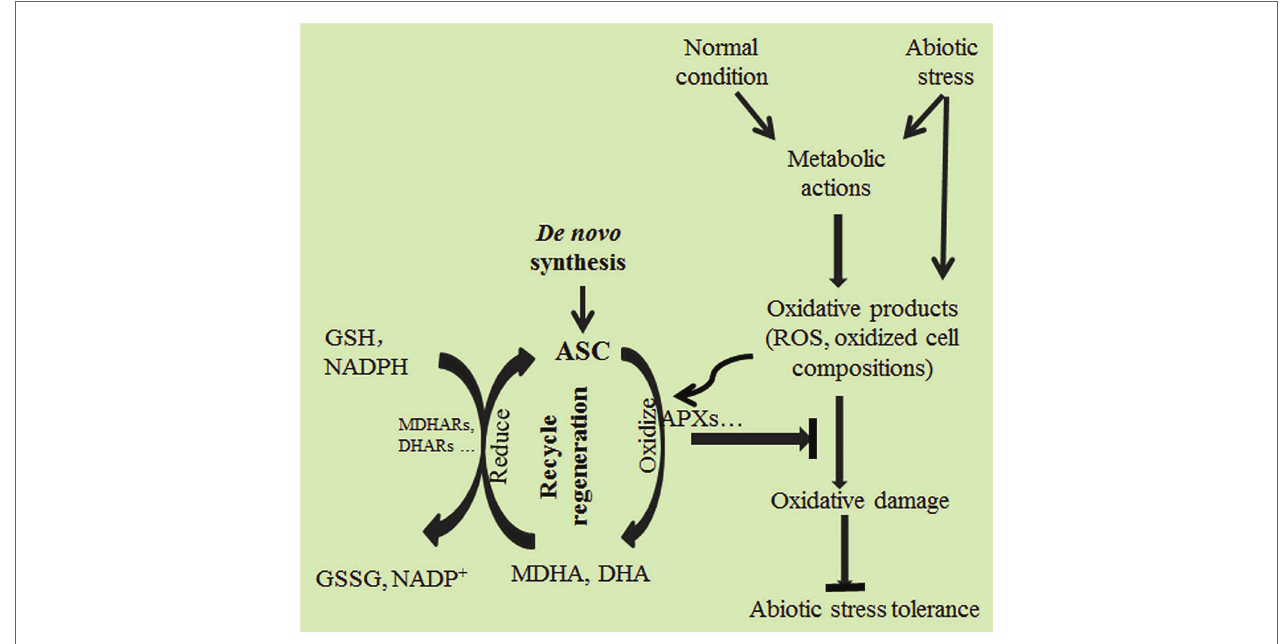
FIGURE 1 | Ascorbate (ASC) effectively scavenges reactive oxygen species (ROS), eliminates oxidative stress, and enhances abiotic stress tolerance in plants via de novo ASC synthesis and